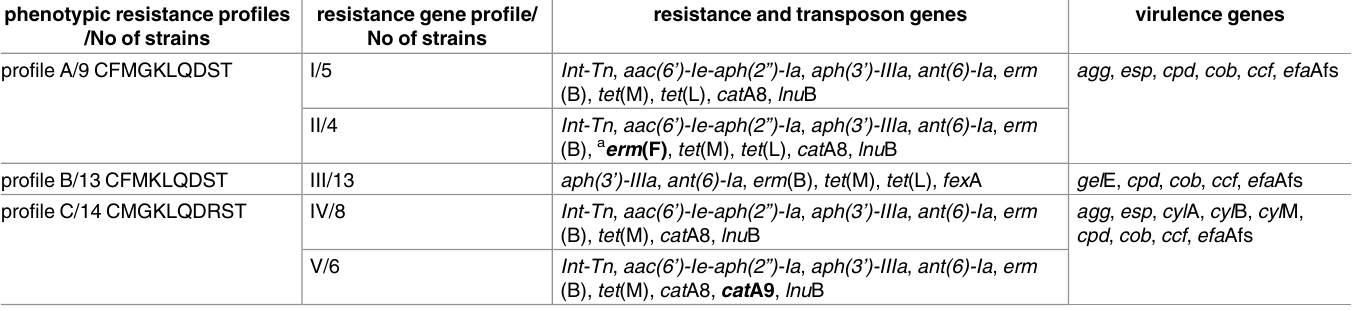
Table 1. Occurrenceof resistance and virulence genes in three selected phenotypic resistanceprofiles of E . faecalis . phenotypic resistance profiles /No of